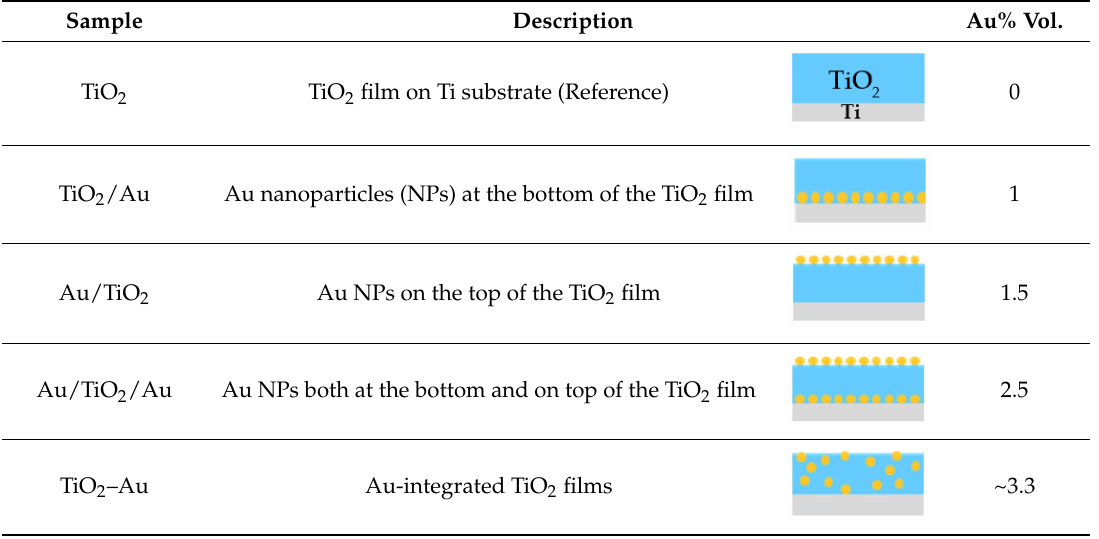
Table 1. Description and schematic representation of the investigated structures. All samples have a nominal surface of 1 cm × 1 cm and the thickness of the TiO 2 layer was 1000